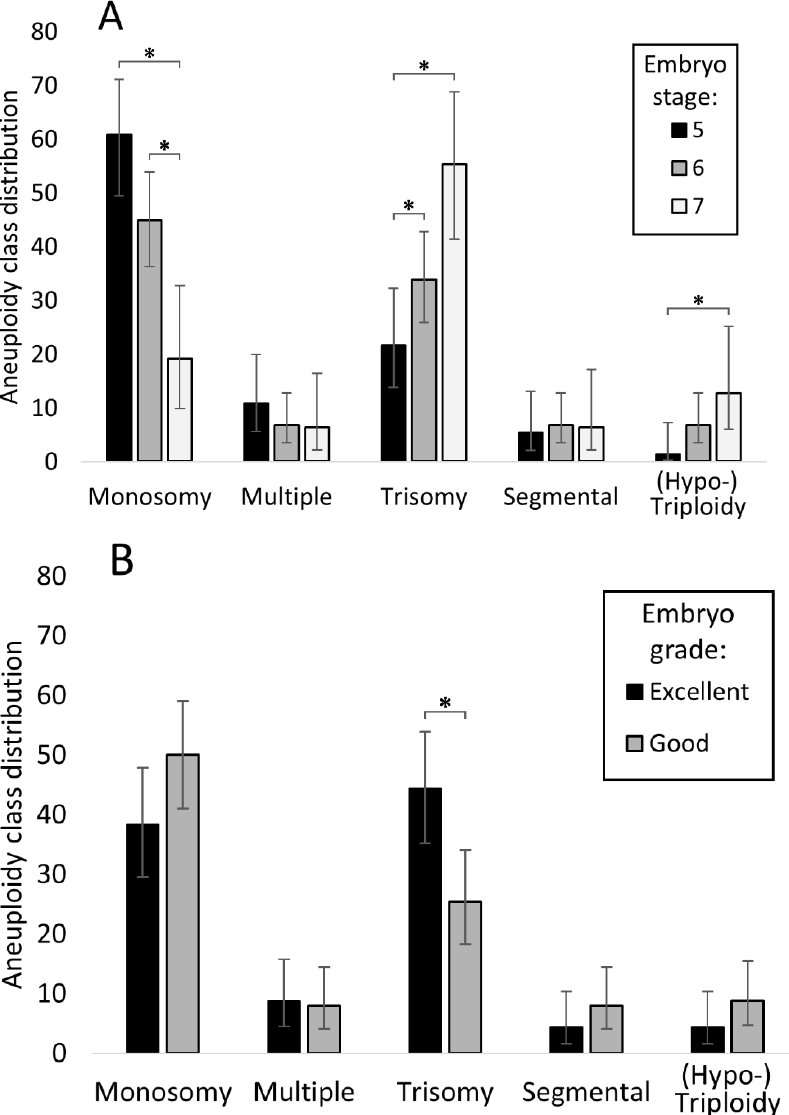
Figure 3. The distribution of aneuploidy types in embryos is affected by developmental stage and morphology grade. ( A ) The proportion of each aneuploidy class changes significantly across different developmental stages, with monosomy being the prevalent form at stage 5 and trisomy at stage 7. Embryos of stages 4, 8, and 9 were omitted from this graph since samples size was less than three in each group. ( B ) Overall aneuploidy class distribution also differed between embryos of “Excellent” or “Good” morphology. Data presented as percentage (%) with 95% CI. * denotes statistically significant differences ( p < 0.01).